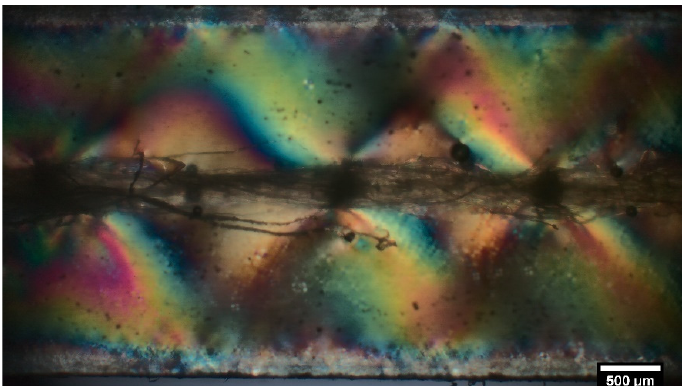
Figure 9. Birefringence effects of fragmented ZnO-coated flax yarns. Table 1. Diameter, critical length ( l c ), debonding length ( l debonding ) and interfacial shear strength values (IFSS) for ZnO-coated flax/epoxy single yarn composite and for neat flax/epoxy single yarn compo- site.